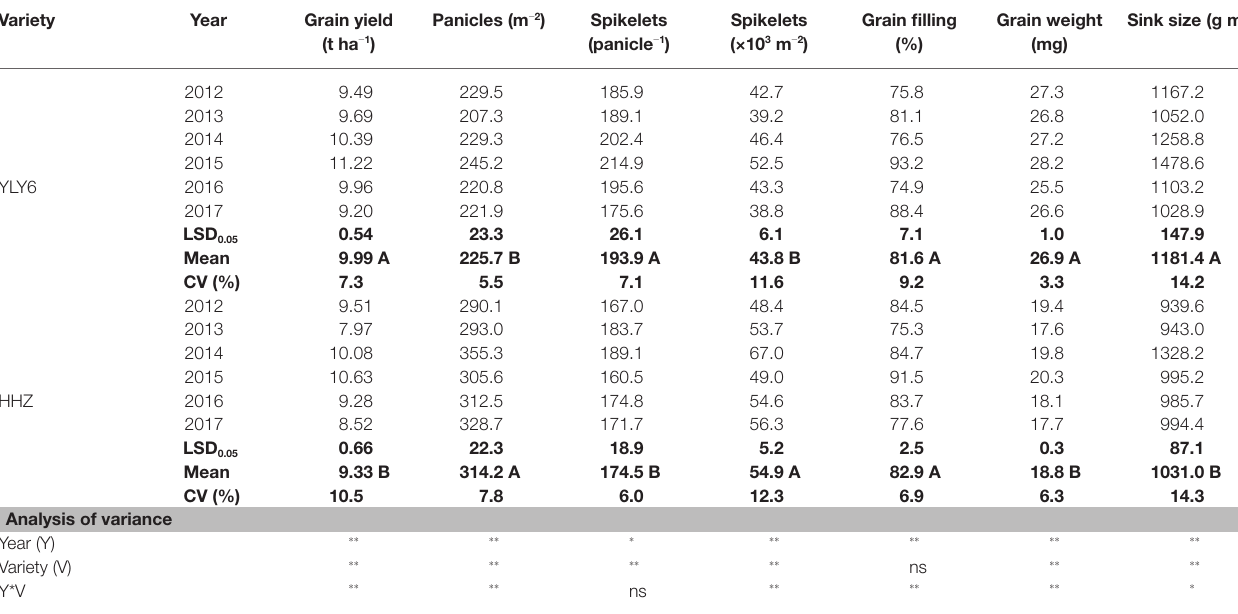
TABLE 1 | Grain yield and yield components of YLY6 and HHZ from 2012 to 2017.